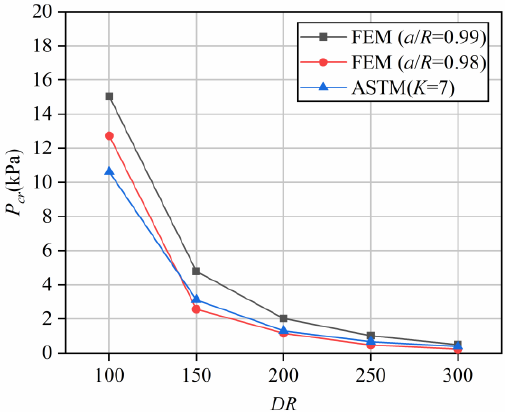
Figure 8. Comparing the influence of increasing DR for critical buckling pressure under different a / R .